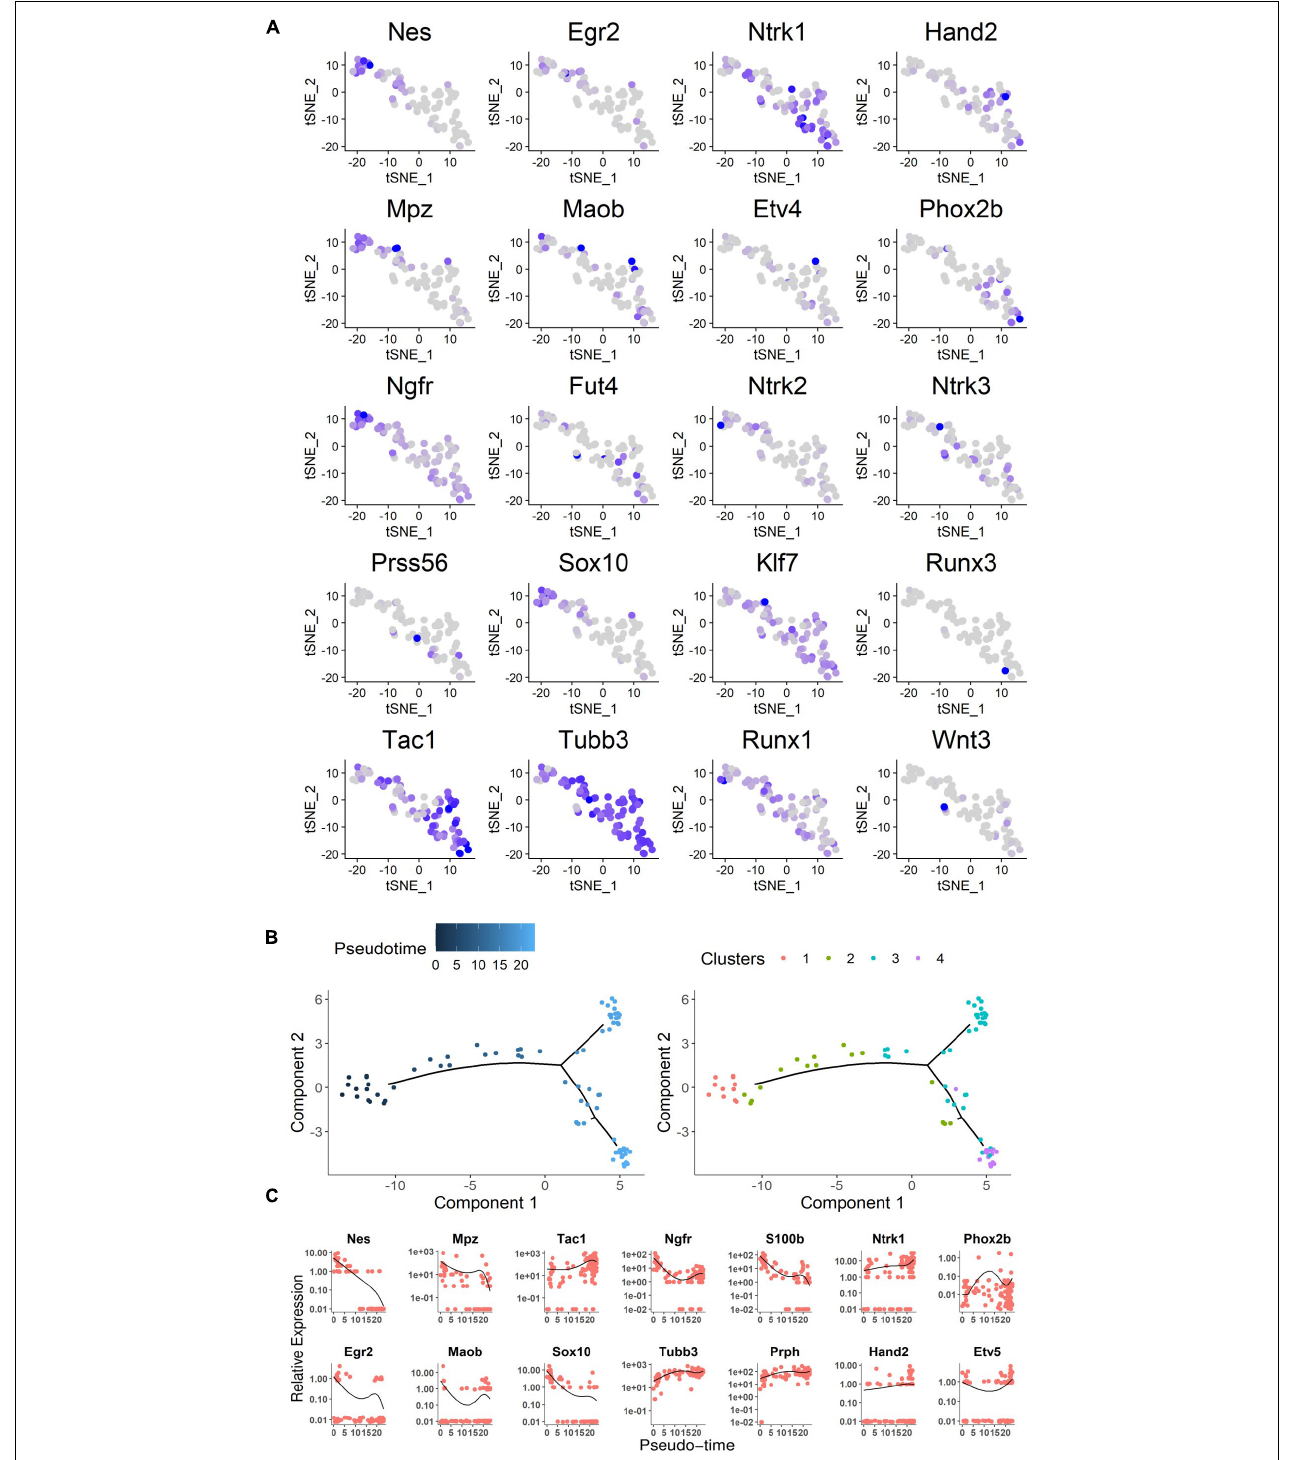
FIGURE 5 | Analysis of neuronal cell single-cell sequencing data. (A) Expression profile of neural crest differentiation-related genes in the t-SNE map. Blue gradient represented the level of gene expression. (B) Expression profile of representative genes along the pseudo-time. Cells were ordered on the x pseudo-time axis by development of neural stem cells. Relevant gene expression was shown on the y axis as transcript counts (the black line was the running mean of expression with a window size of all cells). Each dot represents a cell. As show on the right, cells are highlighted in the same subcluster color gradient as in Figure 4C . (C) The pseudo-time genes expression level based on expression gradient. The chosen genes were representative examples of pseudo-timed differential expression along the transition from proliferation to differentiation for neural crest stem cells, progenitors, and neurons. See also Supplementary Figure 1 .